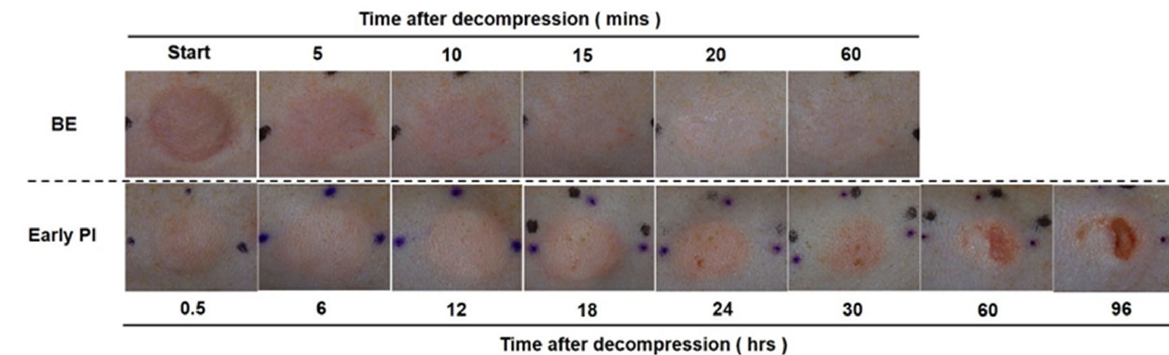
Figure 5. Representative images of macroscopic observation.